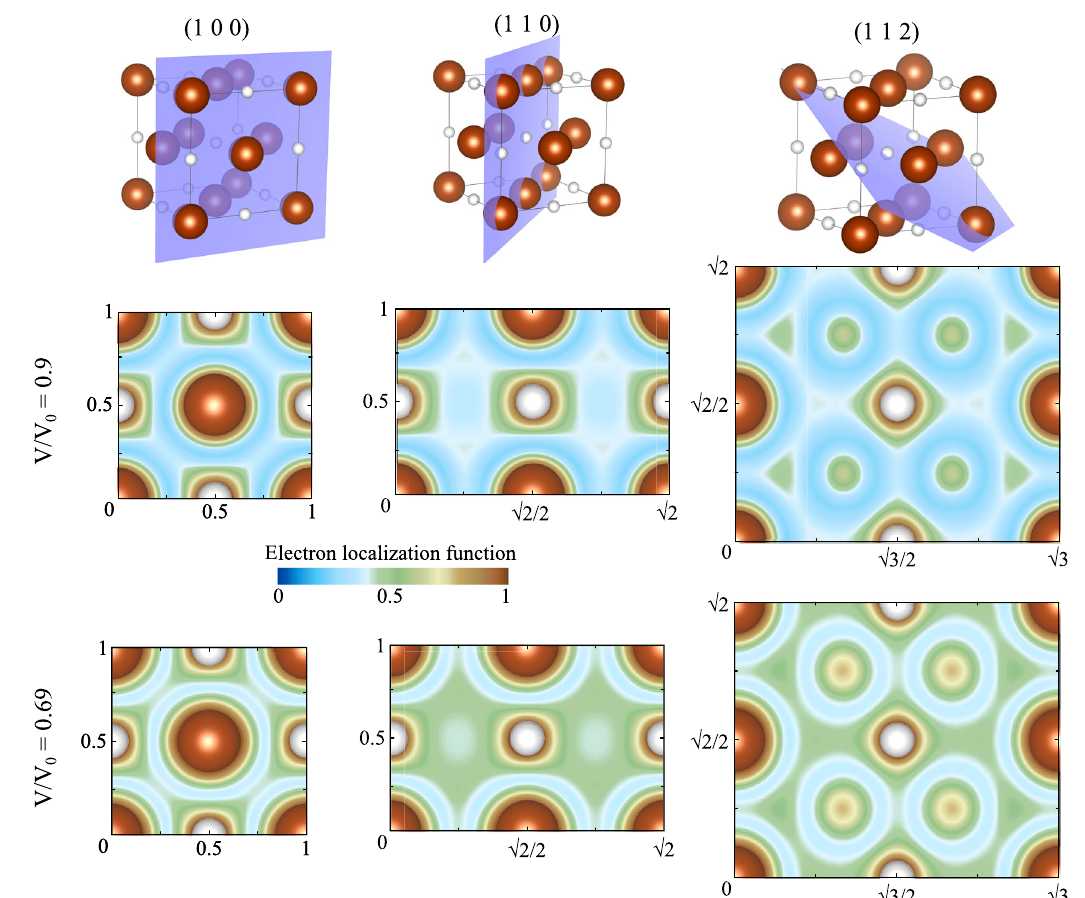
FIG. 5. Electron localization function maps in three major crystal planes at a compression of V=V 0 ¼ 0 . 9 and 0.69, corresponding to 30 and 200 GPa, respectively (for further compression points, see Movie S1 in Supplemental Material [53]). Brown spheres represent iron atoms, white spheres hydrogen. Green areas (ELF ∼ 0 . 5 ) correspond to Fermi-gas-like regions of free